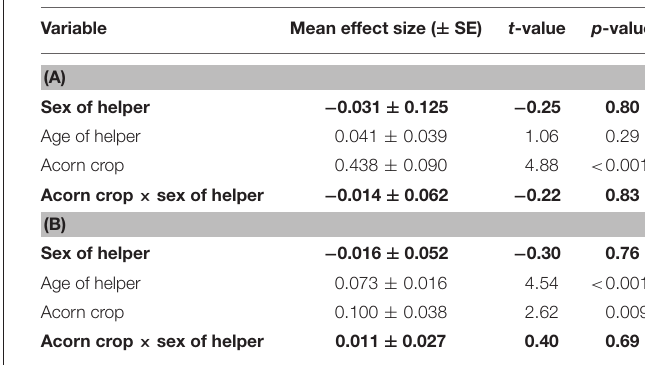
TABLE 3 | General linear models of (A) the proportion of feeding visits in which helpers fed acorns vs. insects and (B) the mean bolus size of food fed to nestlings by helpers.